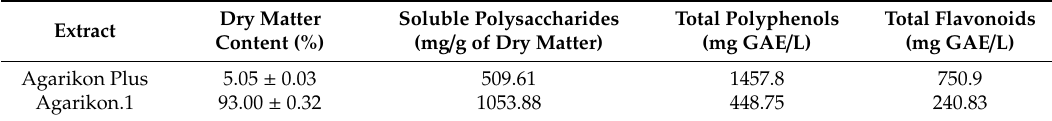
Table 1. Composition of blended mushroom